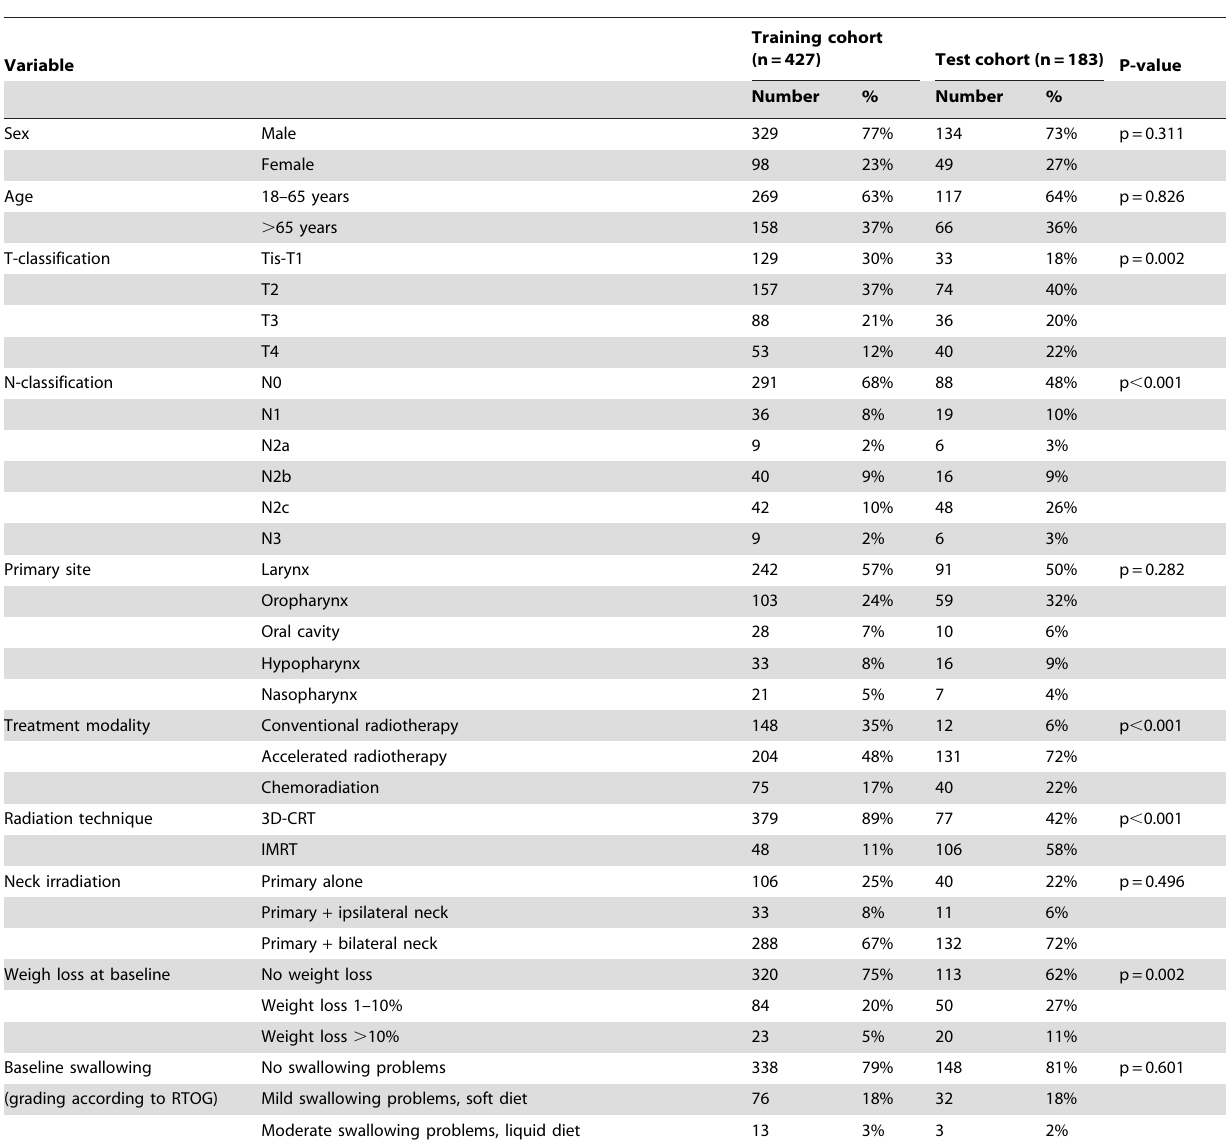
Table 1. Pre-treatment charactistics in the training cohort and test cohort.